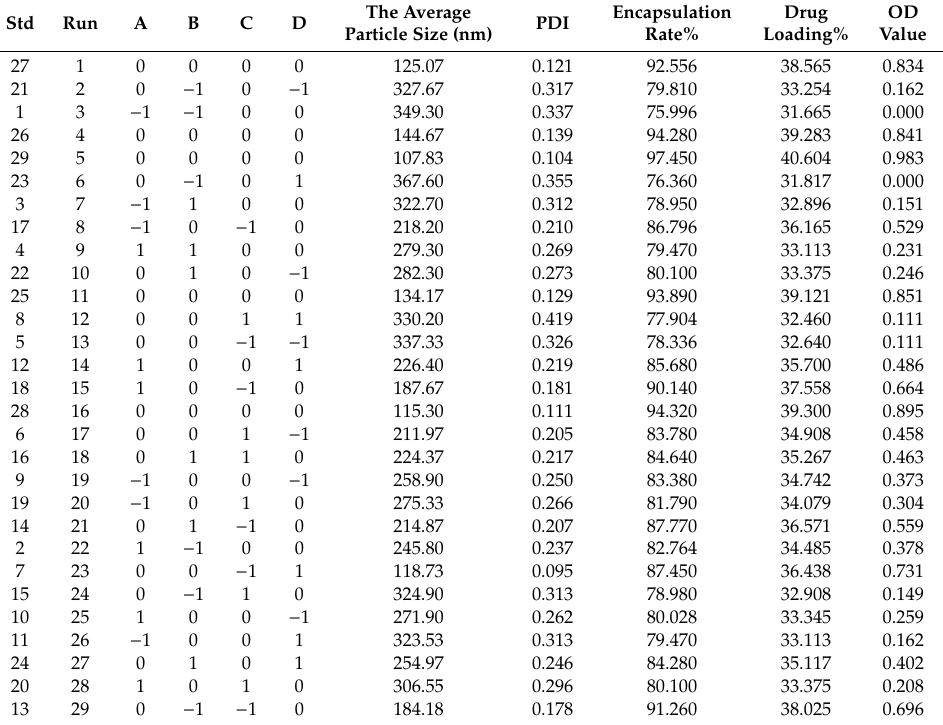
Table 2. Experimental arrangement and results of preparation of puerarin chitosan nanoparticles (Pur-CS / TPP-NPs) Box–Behnken response surface by ion gelation ( n = 3, x ± s). Std